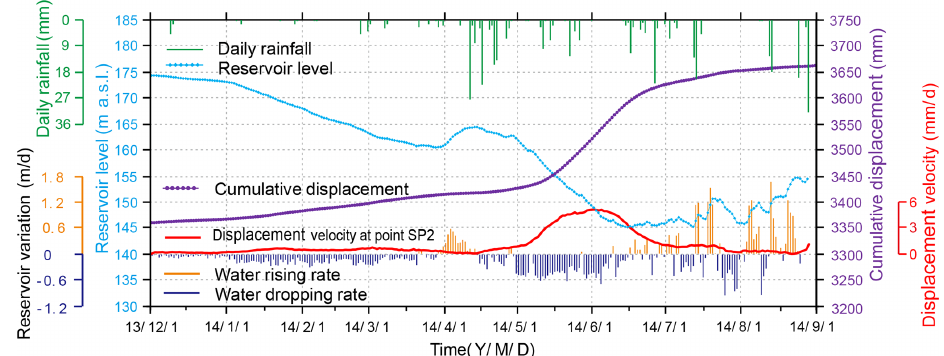
Figure 11. Monitoring data of GPS point SP2 on the middle part of slide mass, from December 2013 to September 2014.